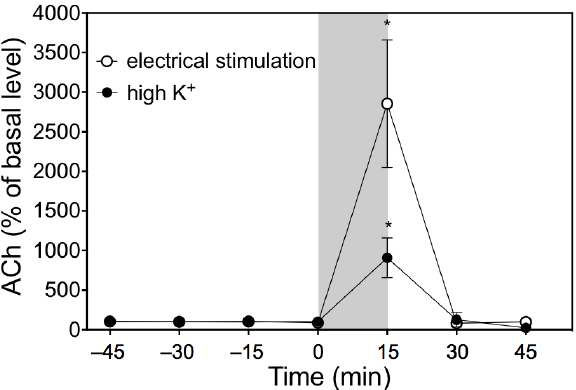
Figure 5. The effects of electrical stimulation of the chorda tympani nerve or perfusion with high-K + Ringer’s solution on the acetylcholine (ACh) level in the dialysate. The solid grey bar indicates the length of electrical stimulation or perfusion with high-K + Ringer’s solution. The values are means ± SD of 4 rats and are expressed as percentages of the basal level. Significantly different from the fraction at 0 min according to Dunn’s post-hoc test following Kruskal–Wallis test; * p < 0.05.